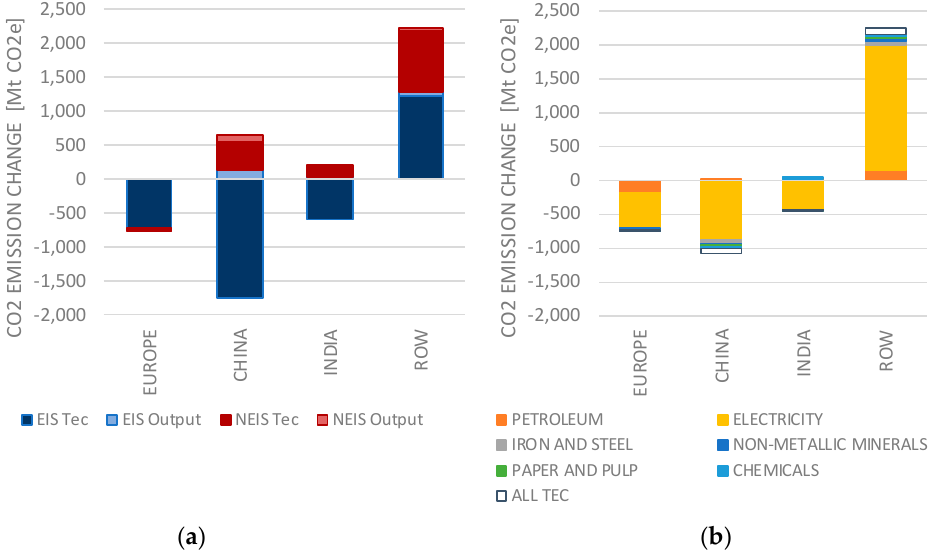
Figure 9. Change in CO 2 emissions by region in 2030 for low carbon technology scenario relative to economic baseline : in energy intensive (EIS) and non-energy intensive (NEIS) sectors ( a ); and triggered by sectoral low carbon technology ( b ).